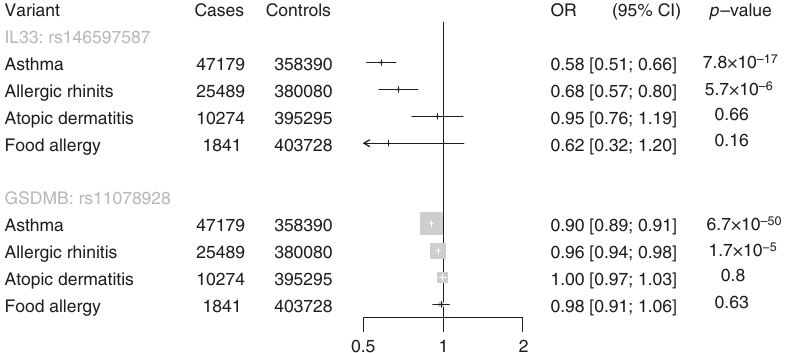
Table 1). A gene-based test combining four additional